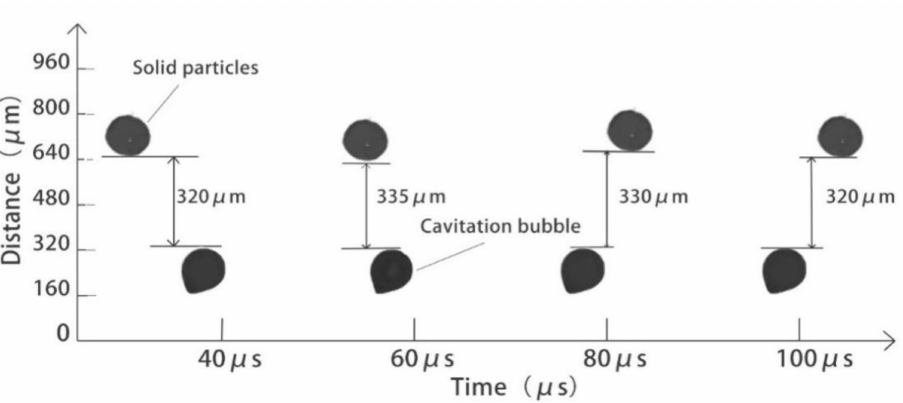
Figure 9. The relative distance between particle and cavitation bubble in flow passage after ultra- sonic